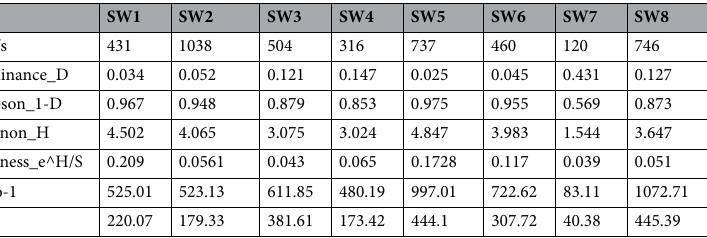
Table 1. Estimated OTU richness and diversity indices of the eight different seaweeds collected from intertidal zones of Mission Rocks, South